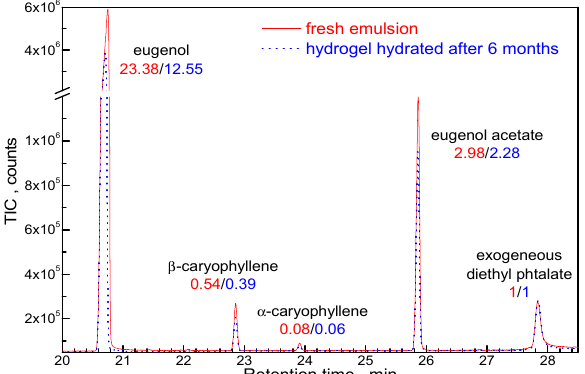
Figure 4. Gas chromatograms of the main organic compounds found in CHH/CEO fresh emulsion and eluted in water from the CHH/T80/CEO xerogel hydrated after six months from preparation.